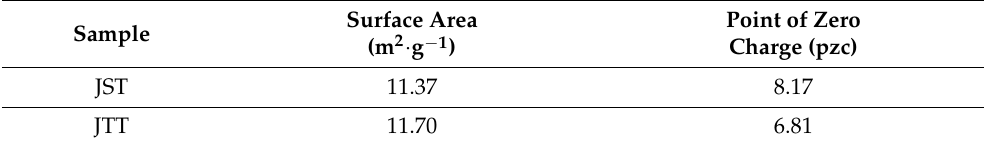
Table 3. Surface area and point of zero charge of JST and